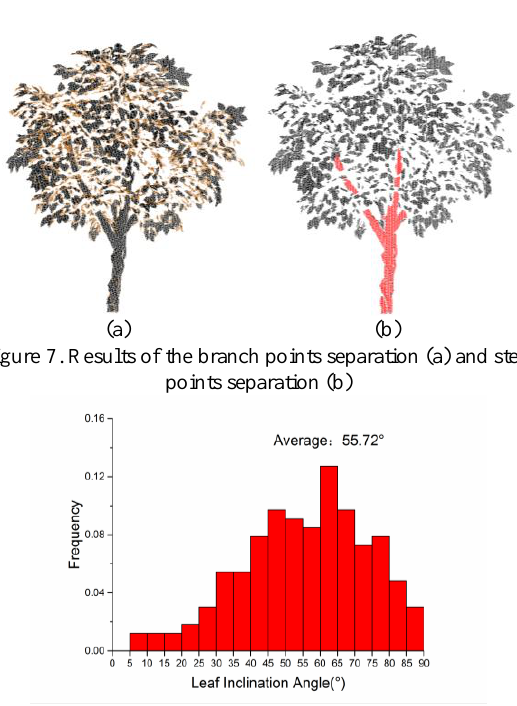
Figure 8. TLS-based LAD histogram of the artificial tree